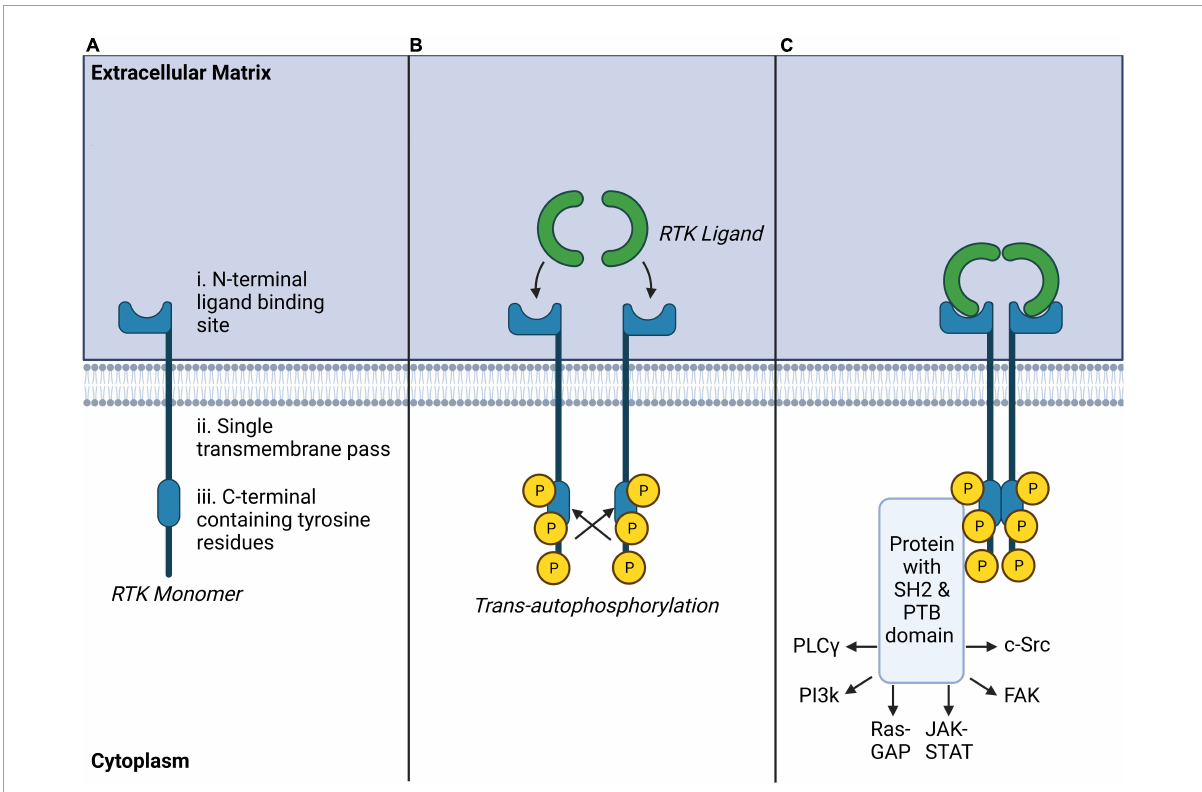
FIGURE2 Receptor tyrosine kinase (RTK) structure, ligand binding and autophosphorylation, and common downstream signaling pathways. (A) RTK monomers are single transmembrane crossing peptides with extracellular ligand binding sites and tyrosine-rich intracellular effector regions. (B) RTK ligands bind as homo or heterodimers to RTKs inducing trans -autophosphorylation of opposing intracellular tyrosine residues. (C) Ligand-bound RTKs typically recruit protein complexes with SH2 and PTB domains which may activate a number of secondary